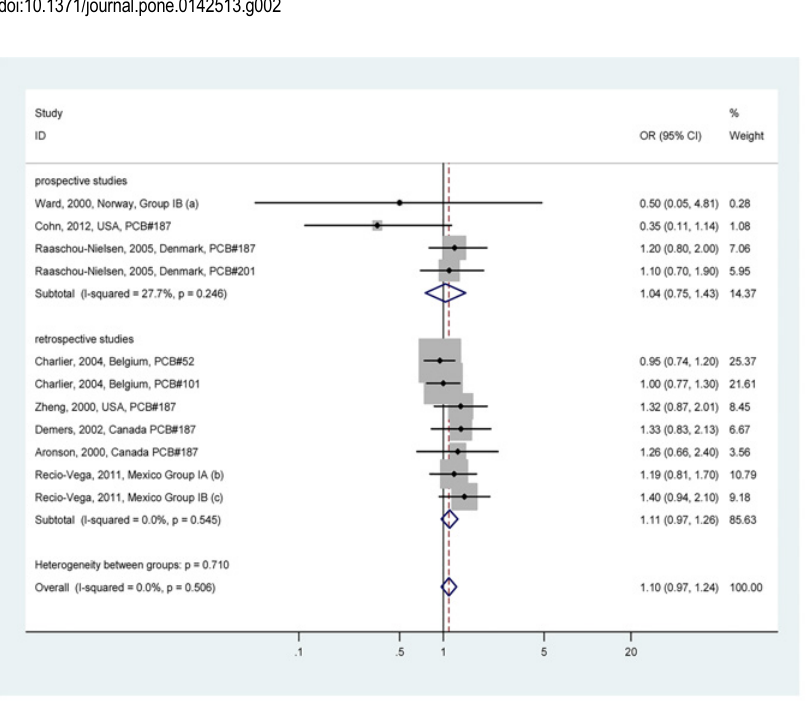
Fig 3. Forest plot describing the association between potentially estrogenic PCBs (Group I) exposure and breast cancer risk. Apart from the overall analysis, the subgroup analyses on prospective (upper panels) and retrospective (lower panels) studies are presented. (a) Group IB includes PCB congeners 177, 187 and 201; (b) Group IA includes PCB congeners 44, 52; (c) Group IB includes congeners 101,